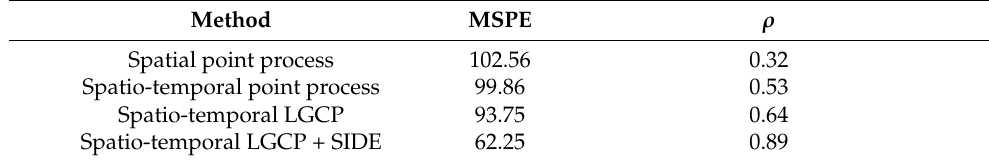
Table 2. MSPE and Pearson correlation coefficients between the log real counts and log predictions of benchmark models and our method for the first 40 weeks of